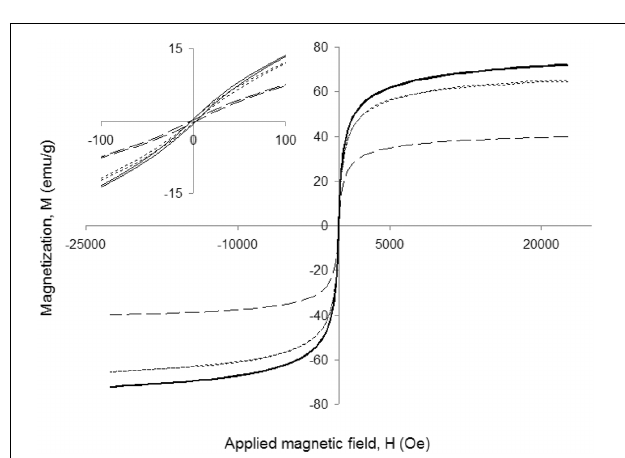
MNPs are 10nm in diameter, the APTS/glutaraldehyde bridge provides a spacer arm of 2.5nm (Dauphas et al., 2009) and the size of CALB is 3 × 4 × 5nm (Uppenberg et al., 1994). TEM images of naked MNPs (C) , MNP-CALB (D) and mCLEA-CALB (E) . Bars represent 20nm in C , and 50nm in D,E .